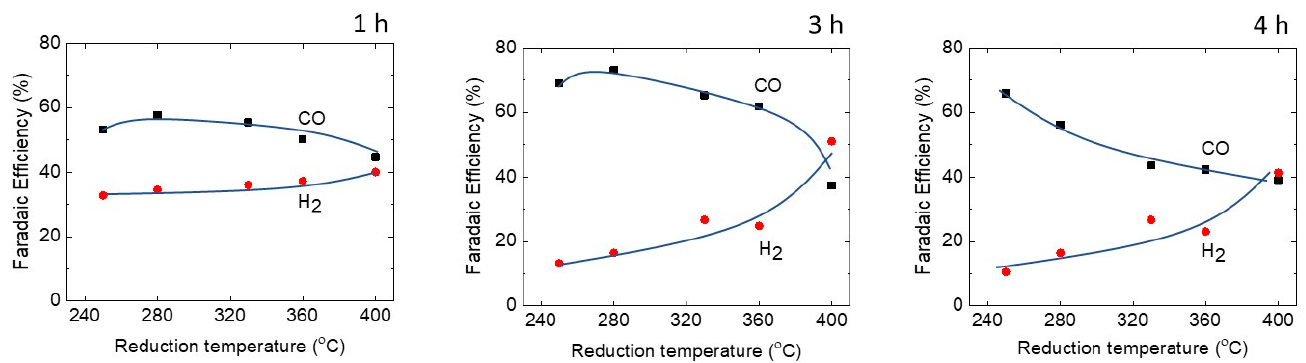
Figure 4. Faradaic Efficiency profiles of hollow fibers calcined at variable times at 600 °C in air (1 h, 3 h, 4 h), as a function of reduction temperature in hydrogen. Efficiencies were determined by chrono amperometry, using 0.3 M KHCO 3 , at ~7–12 mA · cm − 1 , requiring a voltage of − 0.45 V vs. RHE.